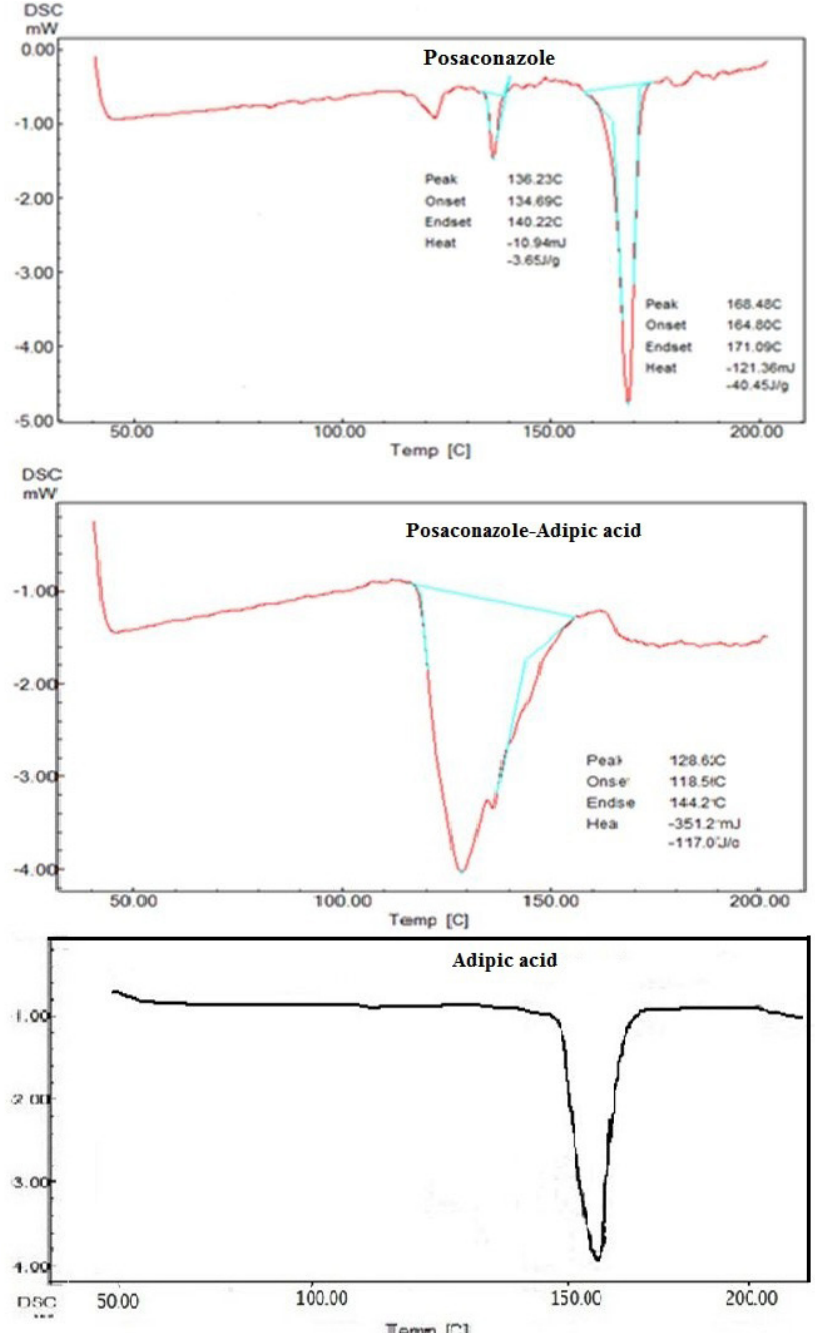
FIGURE 3 - DSC thermogram of posaconazole, posaconazole-adipic acid co-crystals and adipic